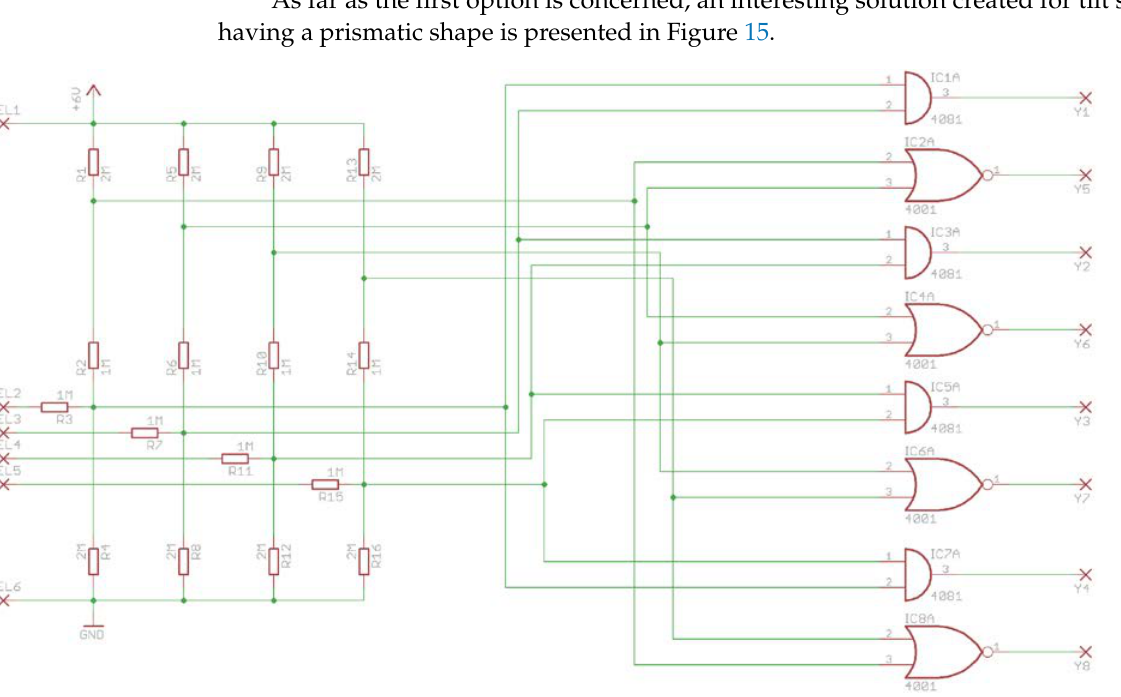
Figure 16. Resistance circuit created for the dodecahedron sensor illustrated in Figure 12b: EL1–EL12, electrodes of the sensor; VO1–VO2, analog voltage outputs .